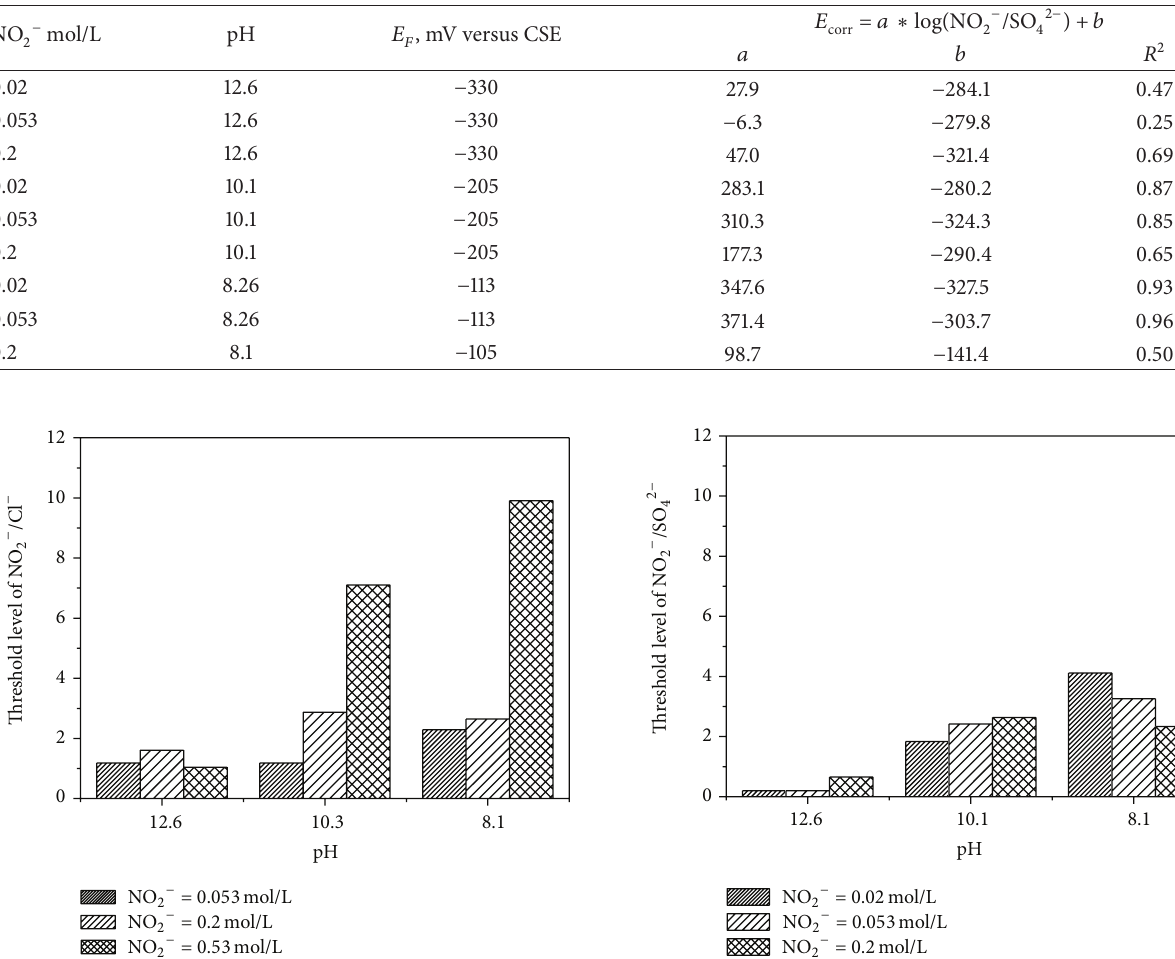
Table 5: Relationship between 𝐸